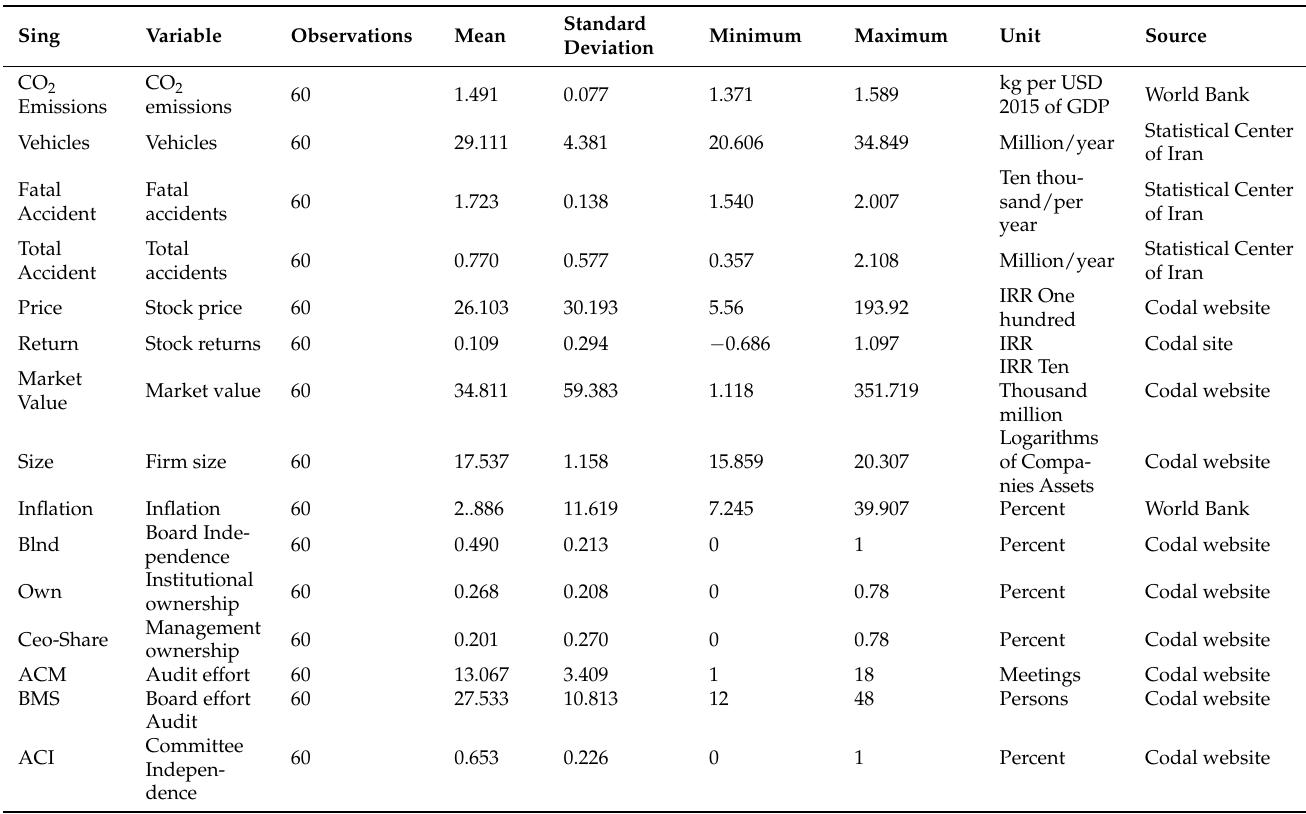
Table 1. Descriptive statistics of quantitative research variables.